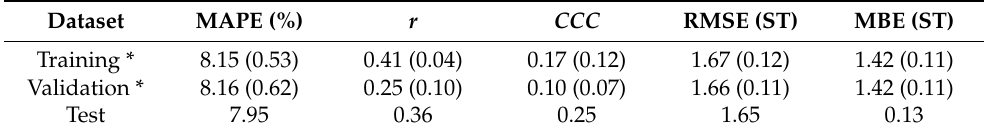
Table 4. Multi-speaker f o model performance on training, validation, and test datasets.